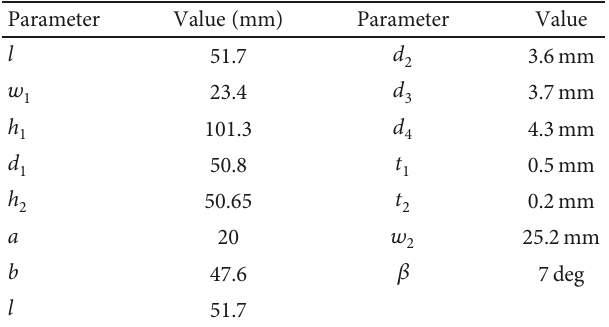
Table 1: Geometric parameters of the wideband HP antenna.